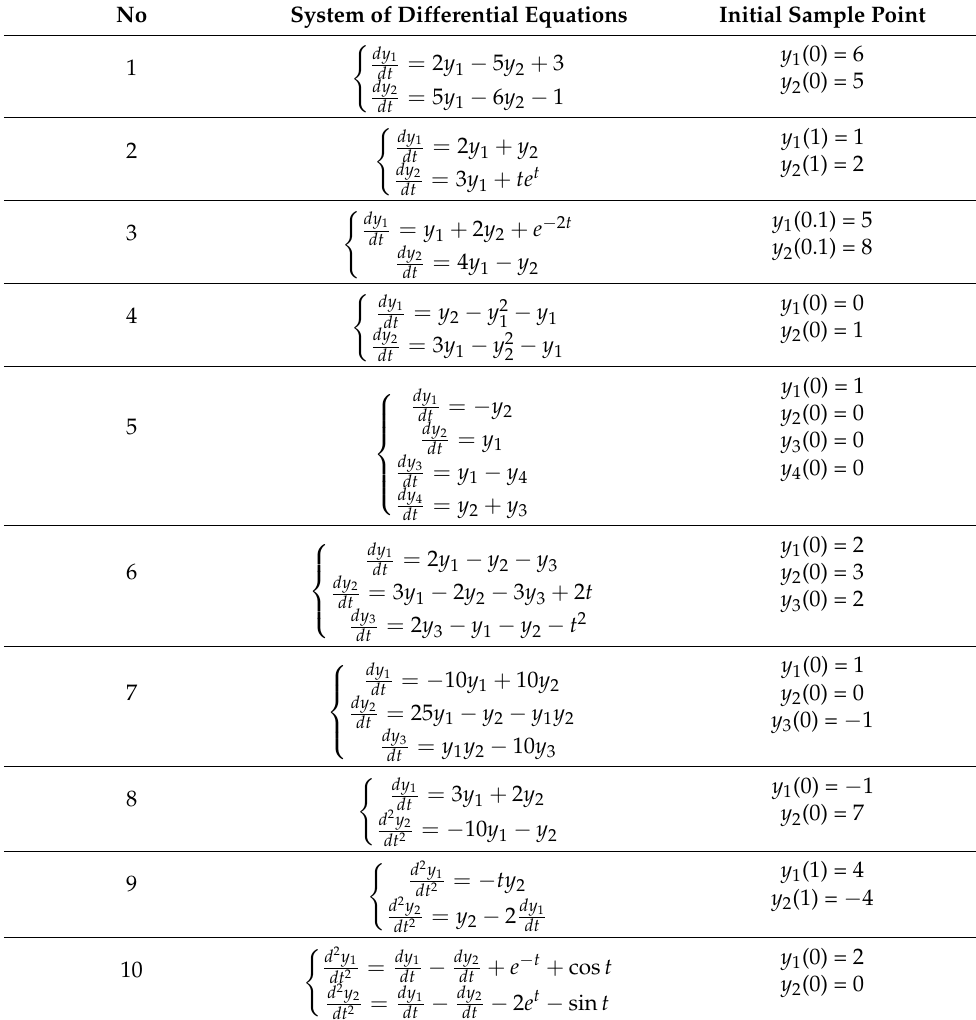
Table 3. Test tasks for the evolutionary approach to the identification of dynamical systems in the form of an ODE